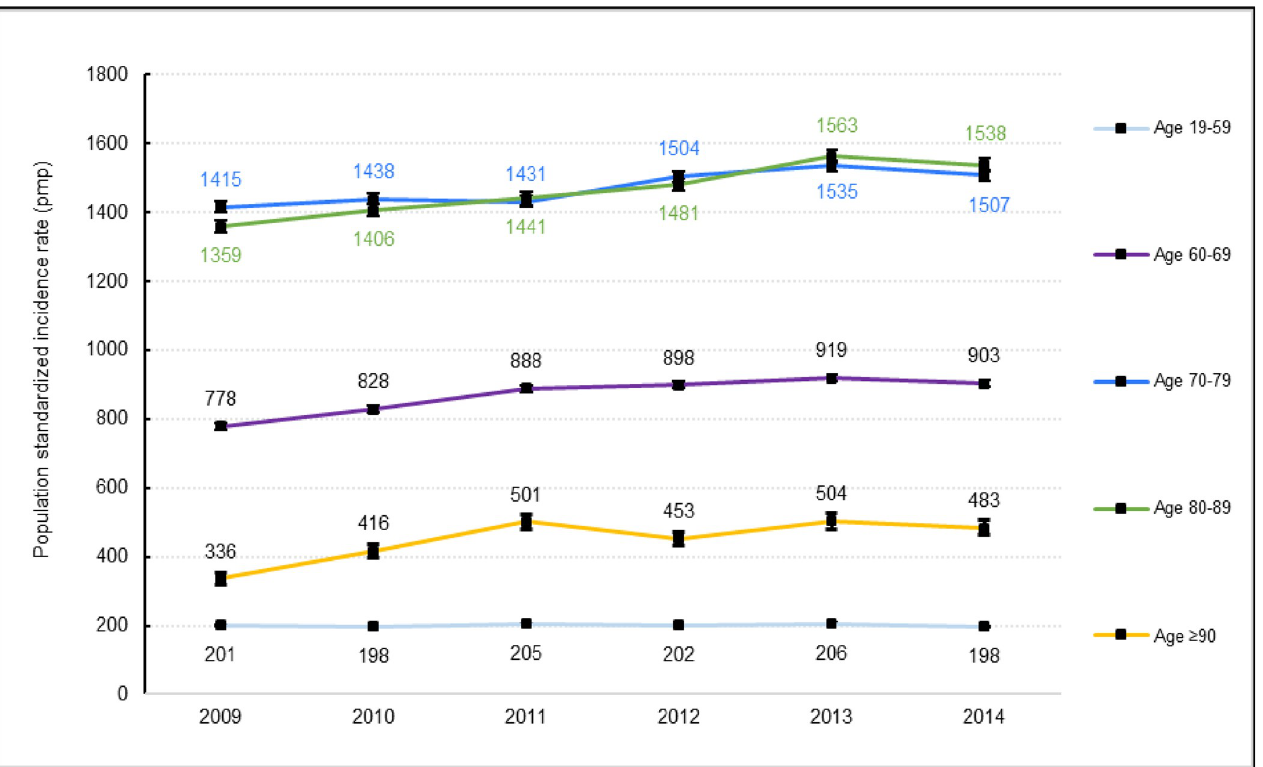
Fig 3. Population standardized incidence rate of acute kidney injury requiring dialysis in metropolitan France by age group from 2009 to 2014. For 2009, the standardized incidence rate was reported as an estimation over 12 months from observations over 9 months. I bars represent 95% CIs for standardized incidence